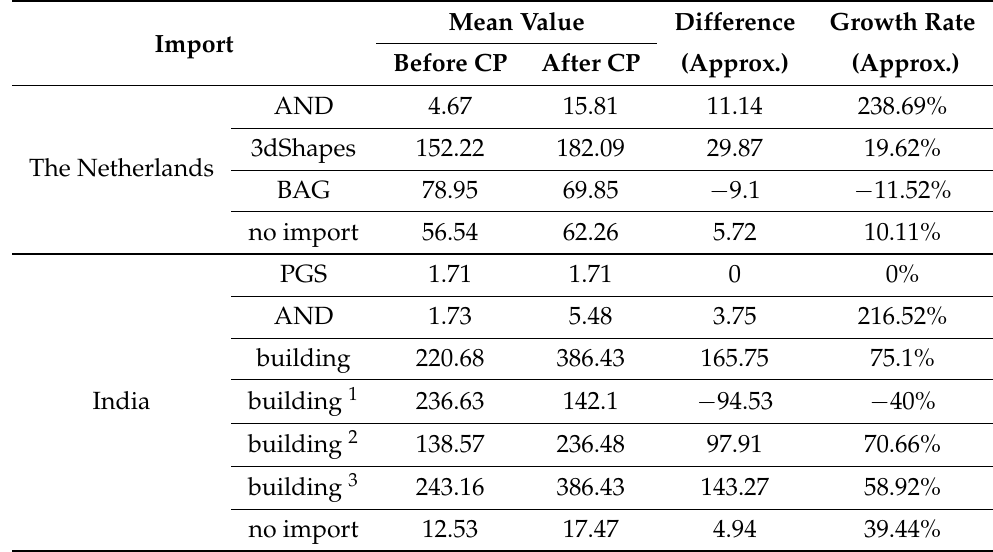
Table 6. Mean value, difference and growth rate for the contributor activity before and after each